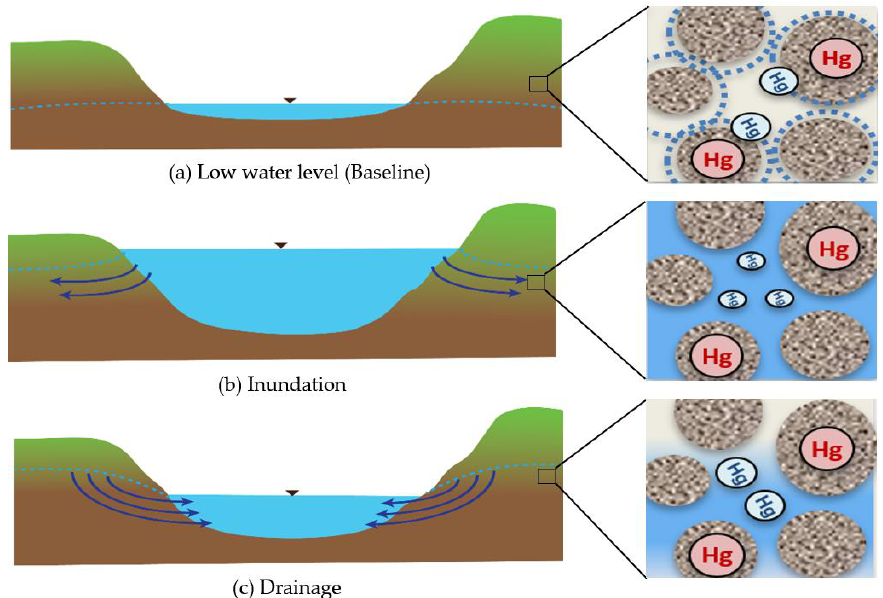
Figure 1. The conceptual model: ( a ) Hg contaminated porewater is not moving because of capillary suction in the unsaturated soil; ( b ) Aerated water inundates the bank and the Hg in porewater can exchange with water; ( c ) Hg Contaminated porewater slowly drains back to the river as the water level recedes.